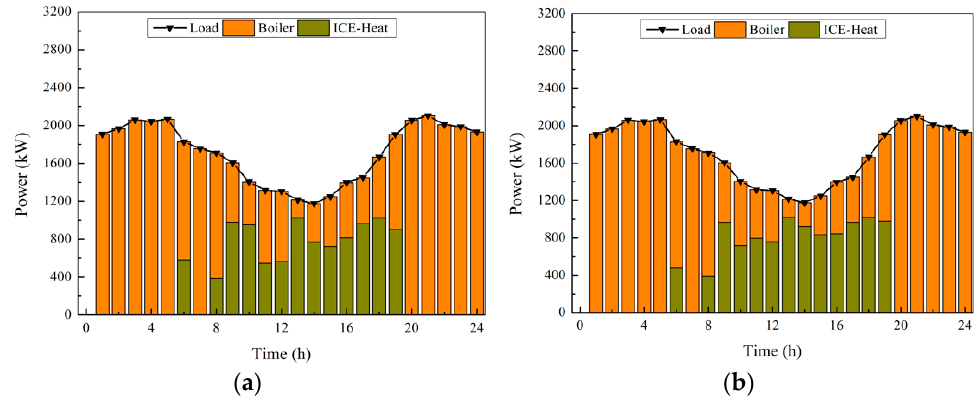
Figure 14. Operational power of heat in winter: ( a ) without considering off-design characteristics; ( b ) considering off-design characteristics.